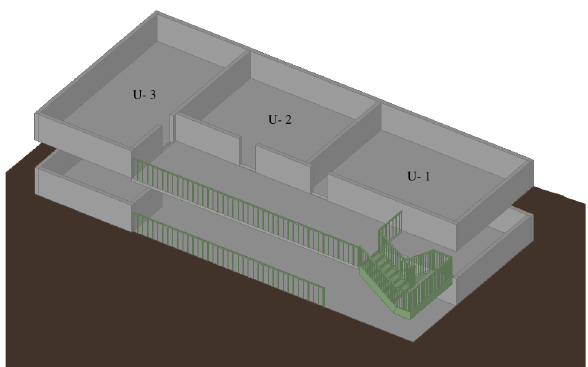
Figure 3. 3D floor plan with a physical boundary.